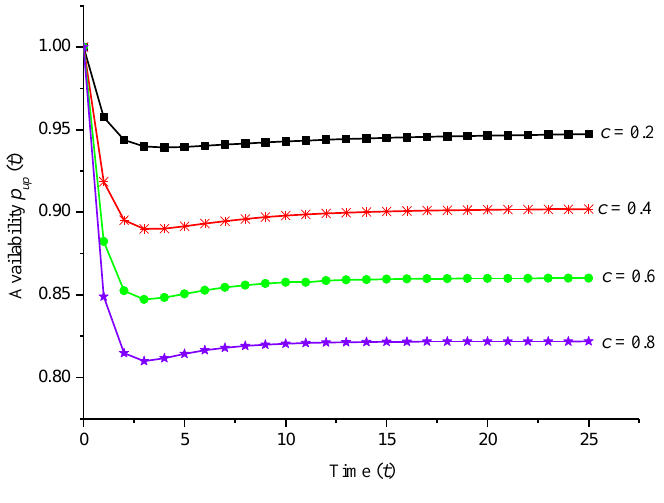
Figure 4. Availability of the system with